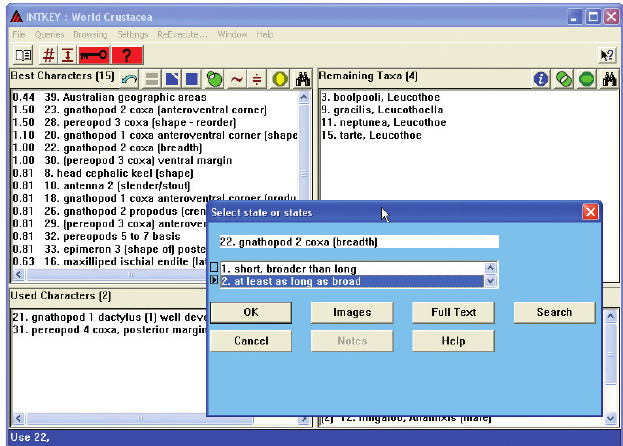
Figure 75. Selecting character states.